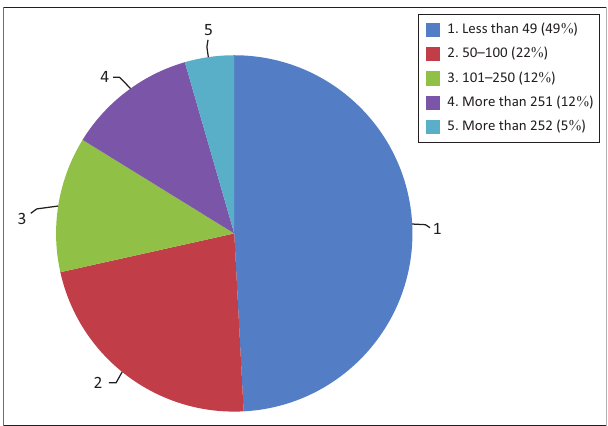
FIG URE 4: Total number of employees in tourism operations.